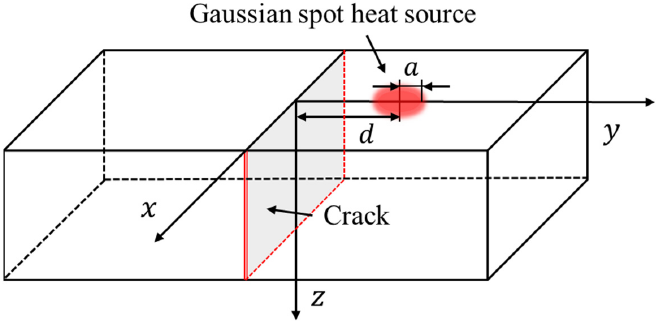
Figure 2. A theoretical model of heat conduction excited by a circular Gaussian heat source [22,28]. Based on Equations (3) and (4), we perform the calculations by MATLAB, and the thermal response of the cracked model under pulse excitation is obtained, as shown in Figure 3. Thus, the influence of material properties and laser power on the distribution of surface temperature and temperature gradient can be analyzed, which provides reference for the simulation and experiment. Several commonly used materials are selected, and their thermodynamic parameters are shown in Table 1. The distance between the circular Gaussian heat source and the crack is set as d = 1 mm, the spot radius of the heat source is set as a = 1 mm (at 1/ e 2 of the intensity), the total energy of the pulse heat source is set as Q 0 = 300 mJ, and the excitation time is set as 0.3 s. The crack width is set as 40 µ m and the thermal resistance coefficient at the crack is R th = L / λ air = 1.74 mm 2 · K/mW. At 0.05 s after excitation, the surface temperature distribution and temperature gradient of the model along y -axis are shown in Figure 3a,b, where the surface temperature gradient T G is defined as: